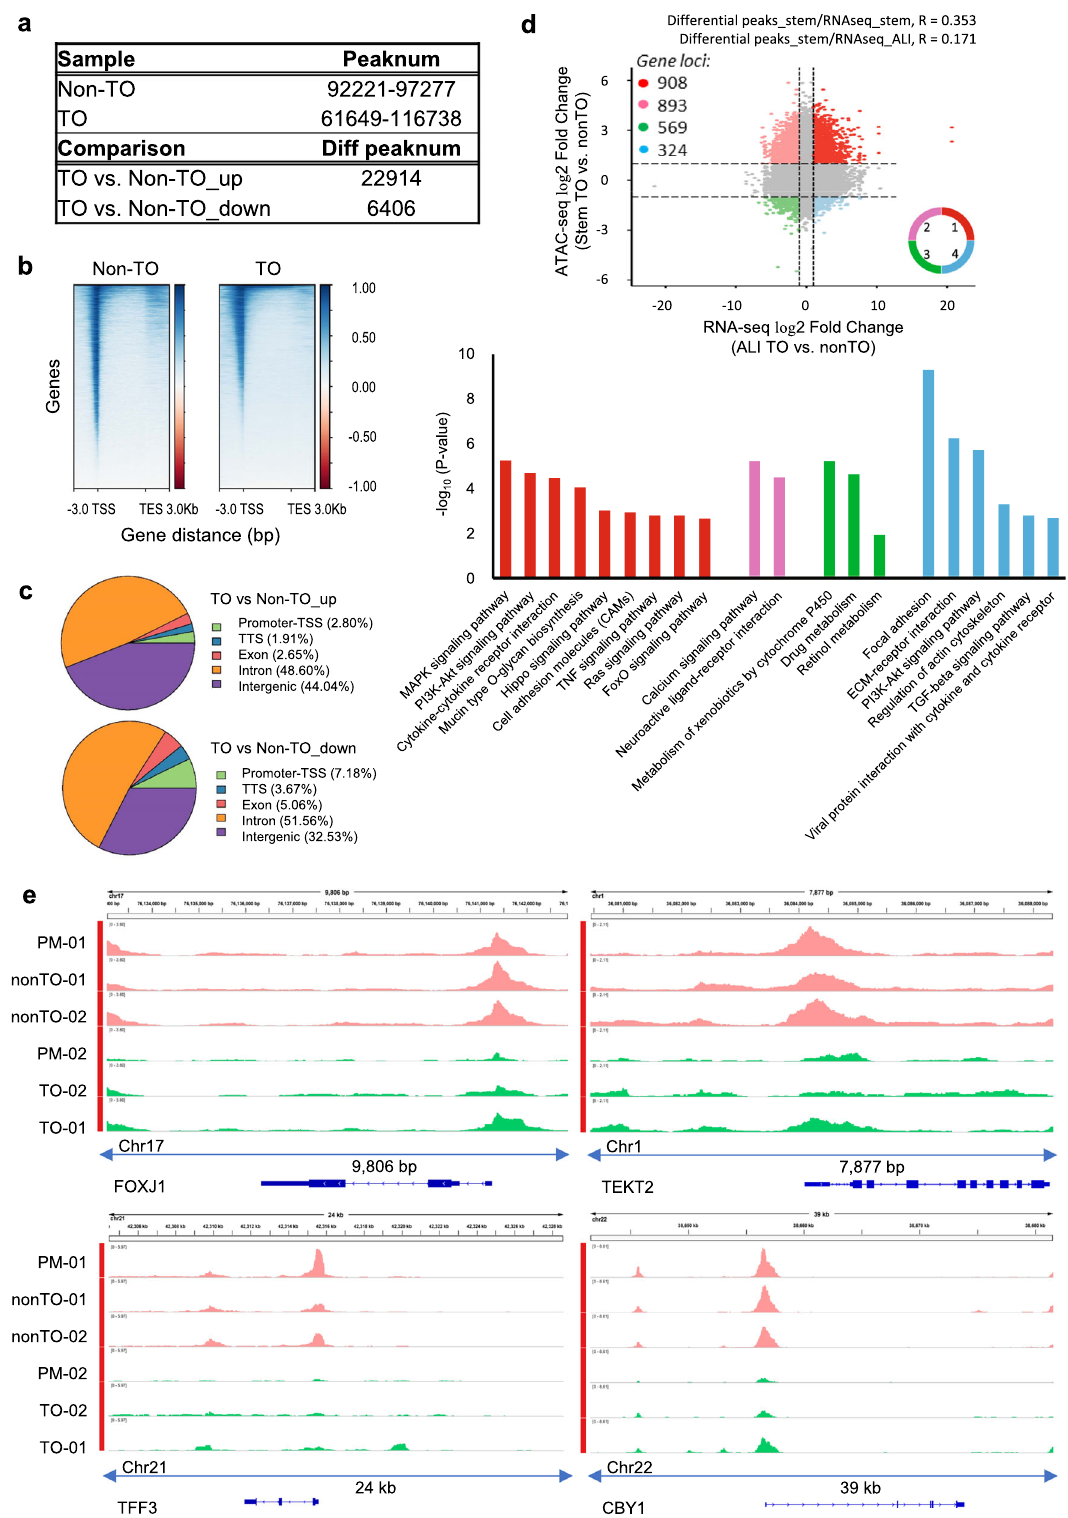
Fig. 7 Chromatin accessibility pro fi les of TO-derived basal cells. a Total peak number and differential peak number in TO versus control. b Heatmap showing reads distributions (from bigwig) across the gene. Genes are represented as lines that are sorted in a descending order based on signal intensity. TSS transcriptional stat site, TES transcriptional end site. c Differentially expressing peaks were annotated and show the distribution in pie charts. d Four- quadrant graph showing the overlaps of genes with altered accessibility and corresponding changes on expression. Vertical and horizontal dotted lines: log2FC = ±1. Pearson ’ s R was calculated between two groups, stem cell ATAC-Seq against stem cell RNA-Seq and stem cell ATAC-Seq against differentiated (ALI) cell RNA-Seq. Pathway enrichment analysis was performed on genes from Quadrant 1 – 4. e IGV plots depicting ATAC-Seq signals at selected gene loci. Peak height is positively correlated to accessibility. Genome-scale is included and the y -axis is consistent for all loci.